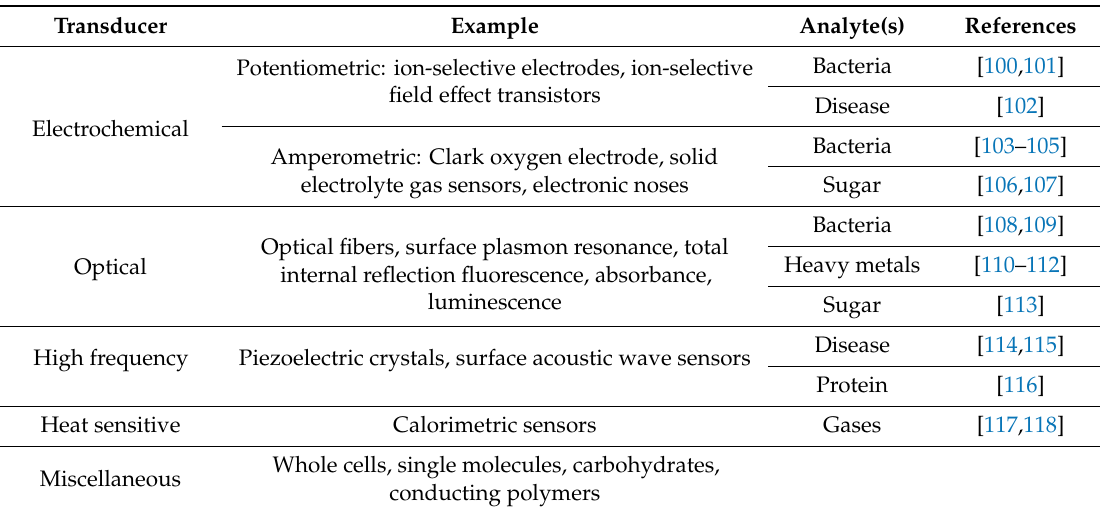
Table 3. Transduction methods used in biosensors